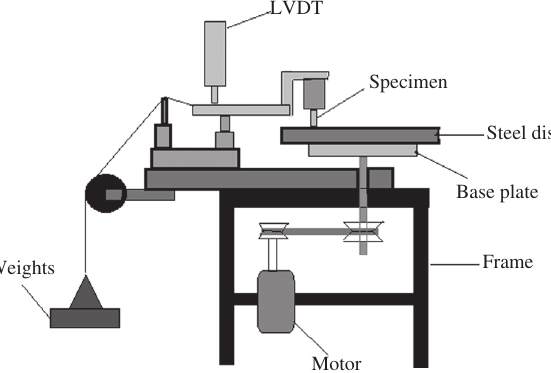
Figure 2 Pin-on-disc wear testing machine setup.